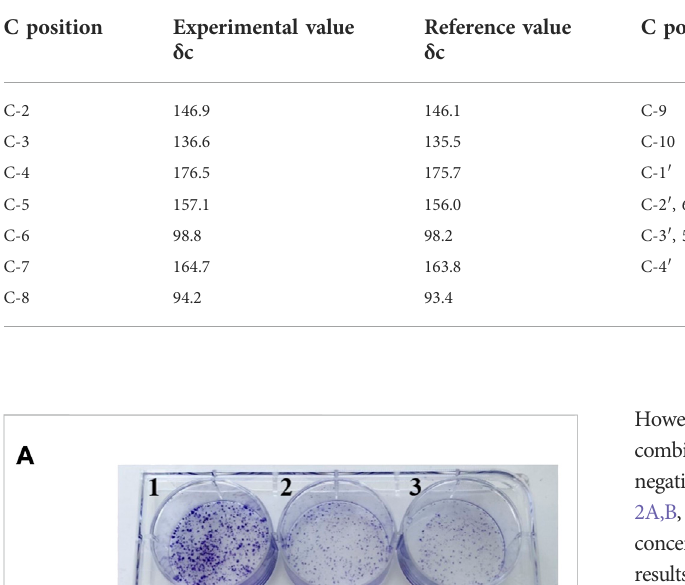
shown in Figure 2A, in HepG2 cells treated with ABT-199 (2 µM) alone, the number of colonies were not signi fi cantly different from the control group, in contrast with KPL alone groups (100 – 200 μ M).